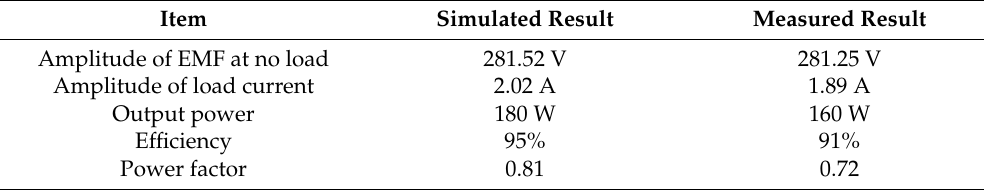
Table 5. Summary of the simulated and measured results (90 Ω and 2500